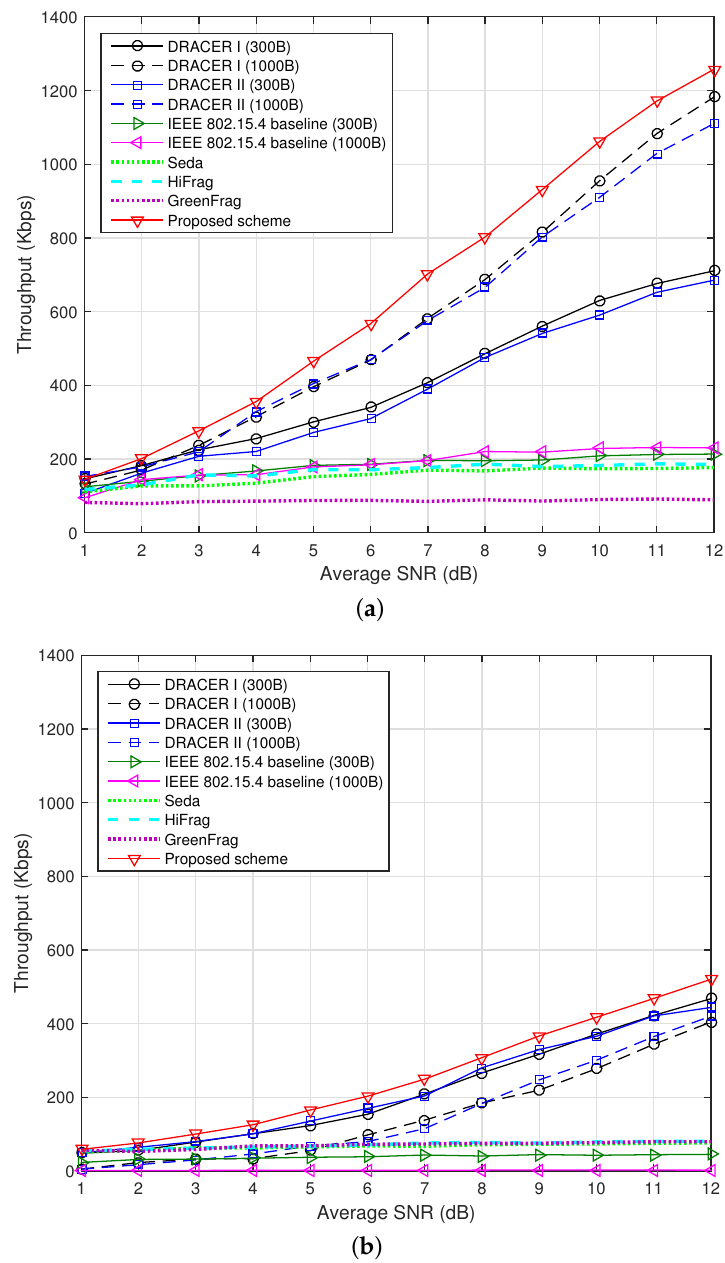
Figure 8. Throughput according to the SNR. ( a ) When ρ = 0; ( b ) When ρ =